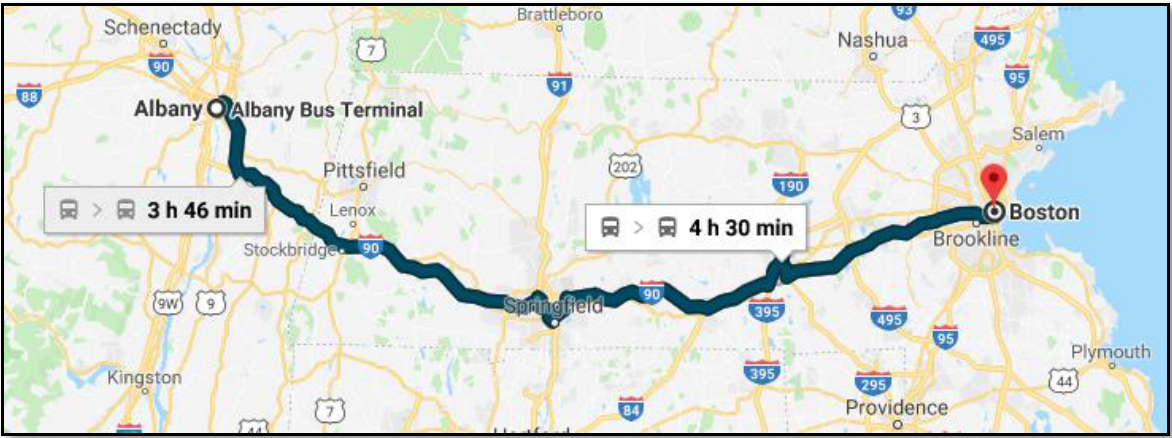
Figure 1. A schematic diagram of the bus route from Albany, NY to Boston, MA. (Source: Google Maps, 2019. Accessed 12 May 2019, Wadsworth Center, Albany, NY 12201-0509).